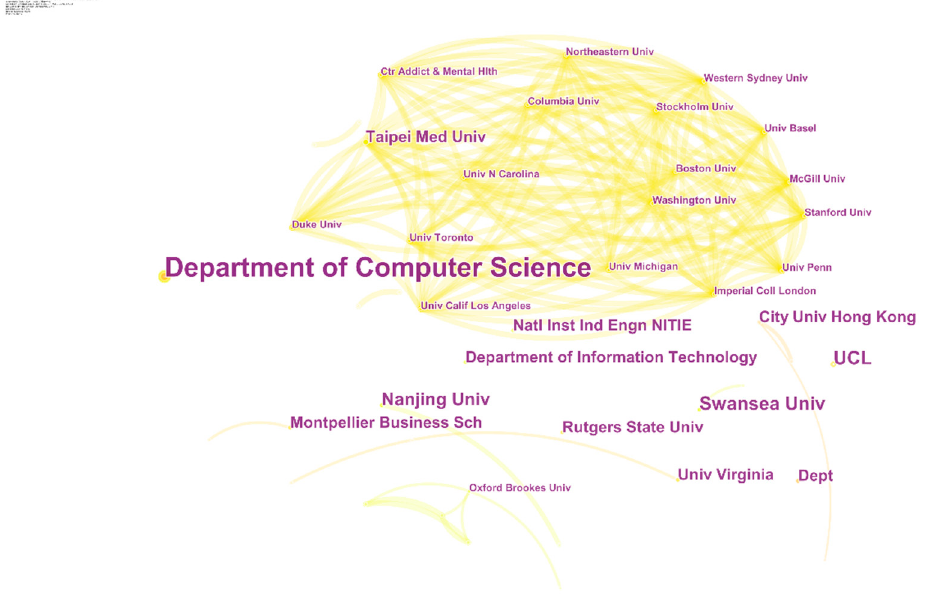
Figure 3. The distribution of institutions (The yellow links represent collaboration relationship between institutions). Table 2. Top 5 institutions according to the number of publications.